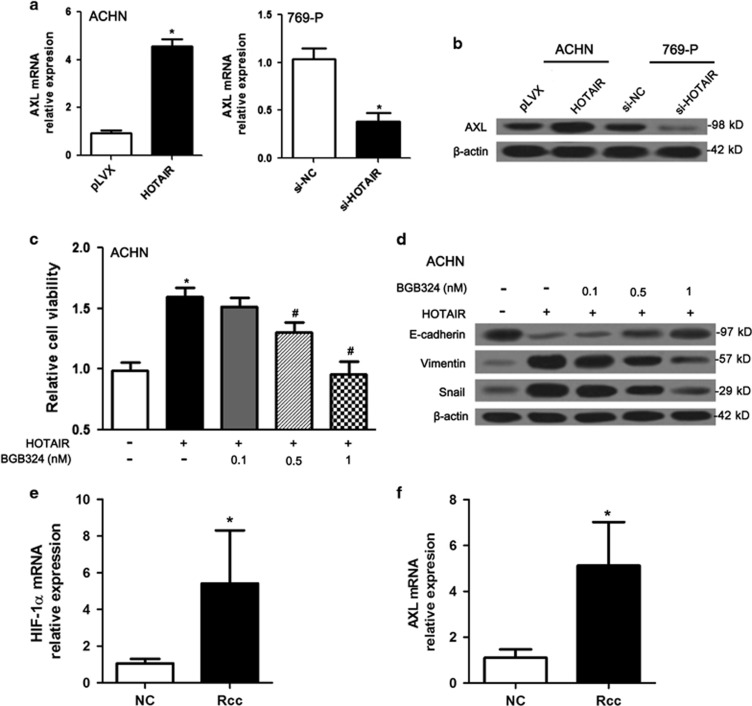
HOTAIR regulates Rcc activity through AXL signaling in vitro. The mRNA (a) and protein (b) expression of AXL in ACHN and 769-P cells. Statistical analysis was conducted by unpaired Student’s t-test. (c) ACHN cells stably transfected with HOTAIR were treated with BGB324 (0.1, 0.5, 1 nM) for 72 h to examine the cell viability. Data were analyzed using One-way ANOVA. (d) The protein expression of E-cadherin, Vimentin, and Snail in ACHN cells stably transfected with HOTAIR and treated with different concentrations of BGB324 were assayed by western blot. The mRNA expression of HIF-1α (e) and AXL (f) in 86 paired Rcc tissues and adjacent histological normal tissues. Data were analyzed paired Student’s t-test. *P<0.05 versus control group, #P<0.05 versus HOTAIR treated only group